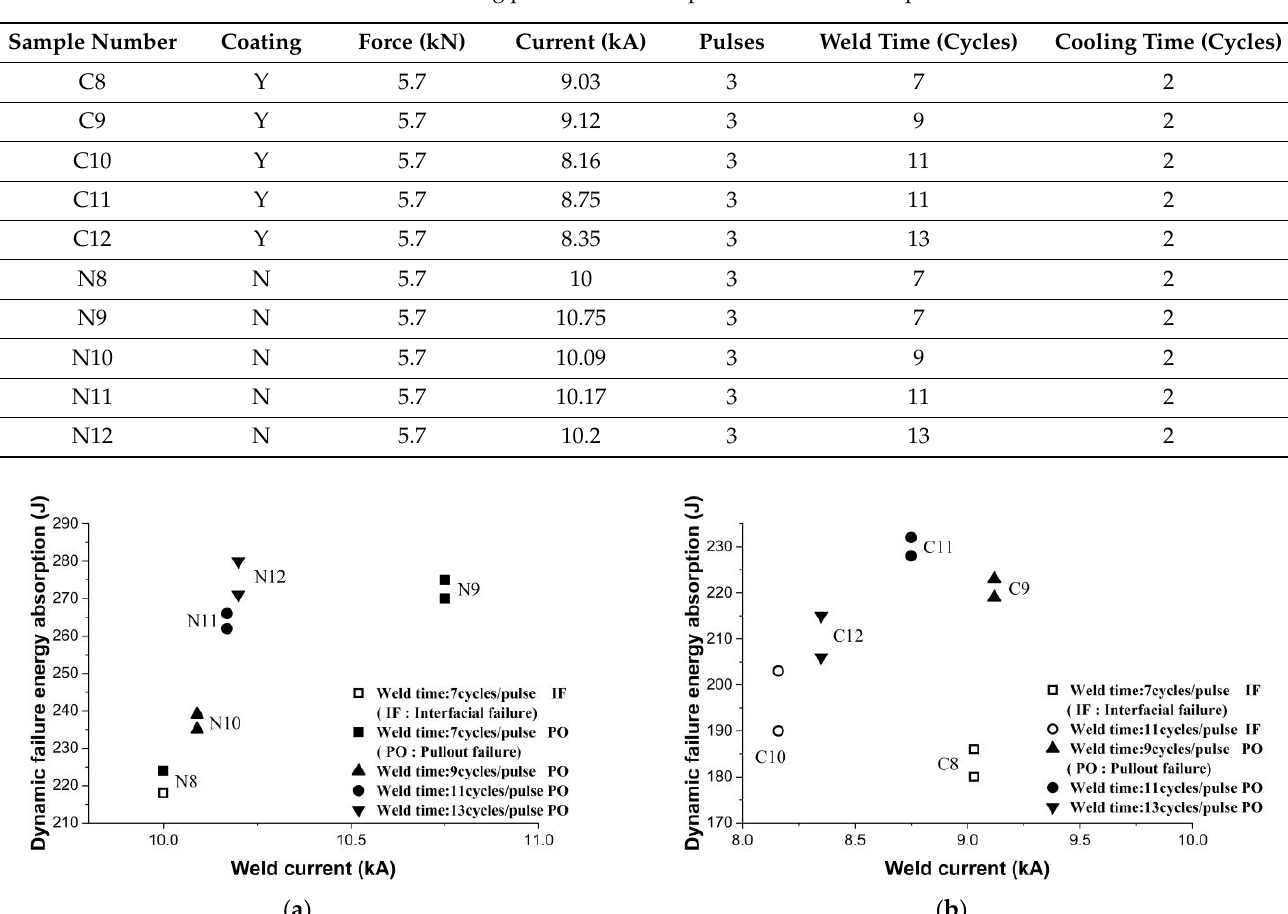
Table 3. Welding parameters for impact tensile shear samples.